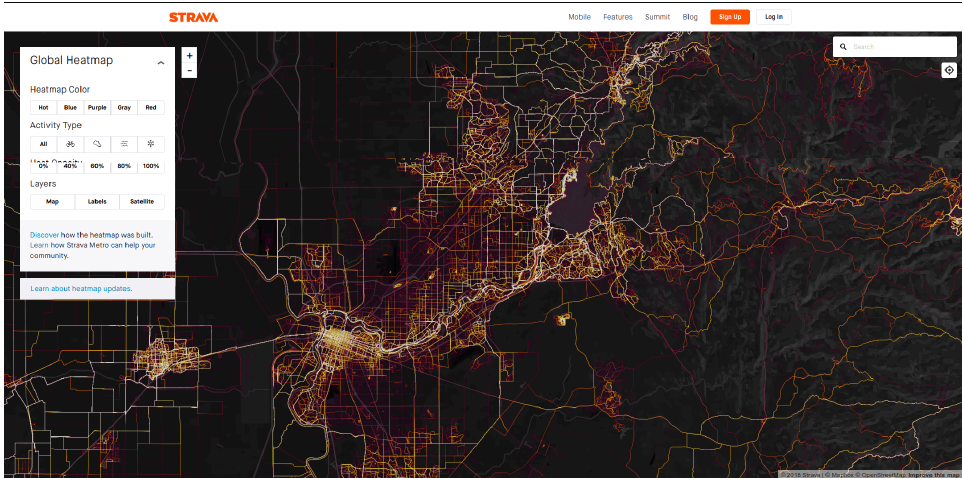
Figure 6. A screen capture, taken 20 March 2020, of the worldwide heatmap (available at https://ww w.strava.com/heatmap) of user data compiled by Strava, Inc. (San Francisco, CA, USA), a company offering geographic tracking for athletics such as cycling. The map can be zoomed and panned, and the aggregated athlete traces presented to the viewer vary by zoom